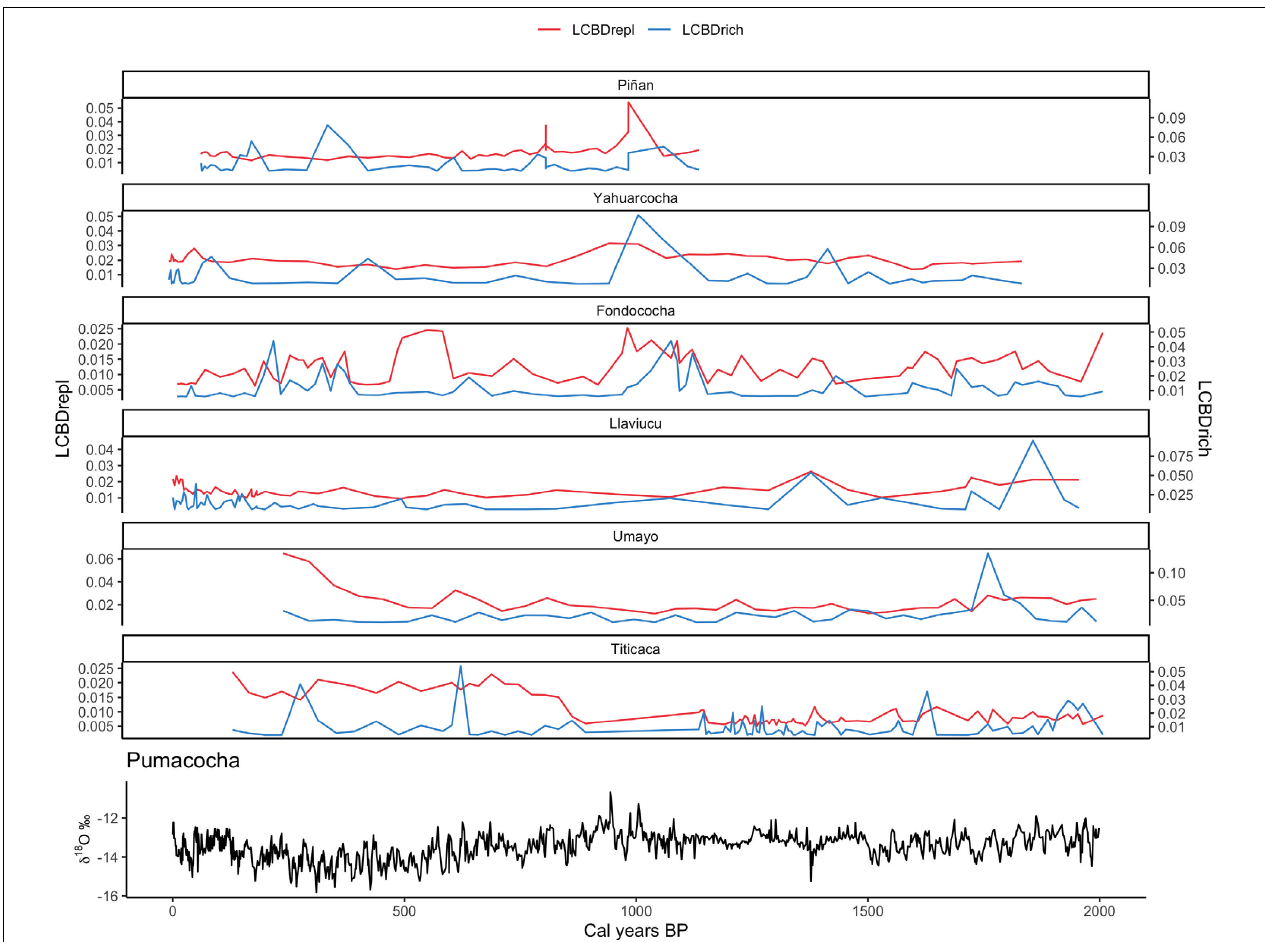
FIGURE 3 | Contribution of replacement (LCBDrepl) and richness (LCBDrich) components to beta diversity for the six investigated lake cores (arranged by increased latitude). Isotopic δ 18 O measurements from Pumacocha lake (Bird et al., 2011) are interpreted as dry periods with enriched values. Note the two y-axes for replacement and richness components of beta diversity time